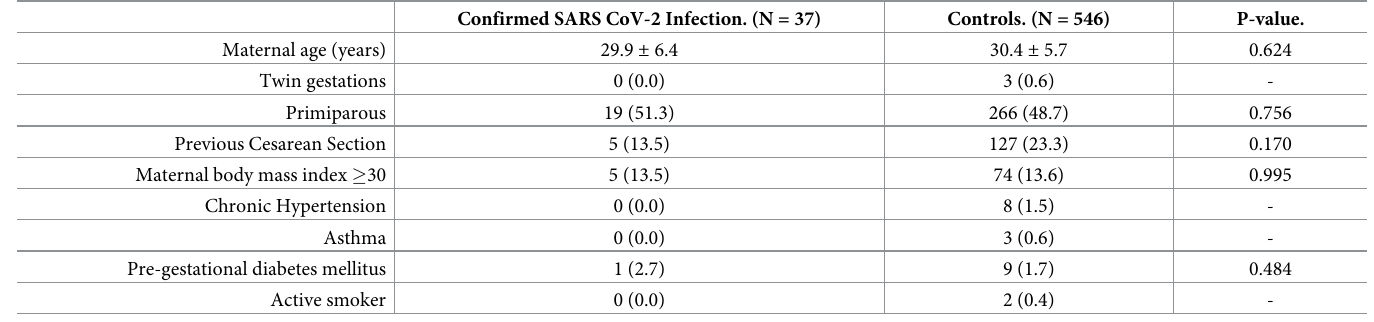
Table 1. Main characteristics of the study population at